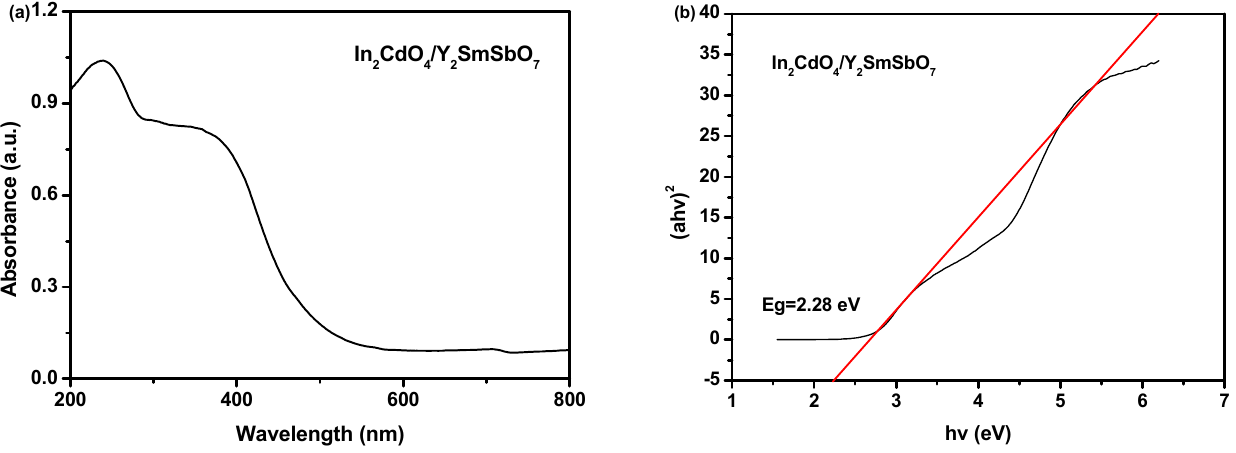
Figure 6. ( a ) UV − Vis diffuse reflectance spectra of In 2 CdO 4 /Y 2 SmSbO 7 heterojunction; ( b ) plot of ( α h ν ) 1/2 versus h ν for In 2 CdO 4 /Y 2 SmSbO 7 heterojunction.